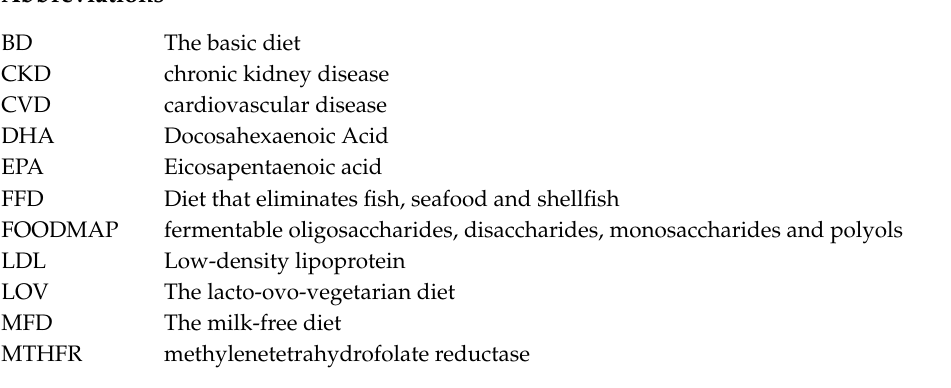
Table S1: Di ff erences in mineral content, Table S2: The presence of statistically significant di ff erences in the content of vitamins between the